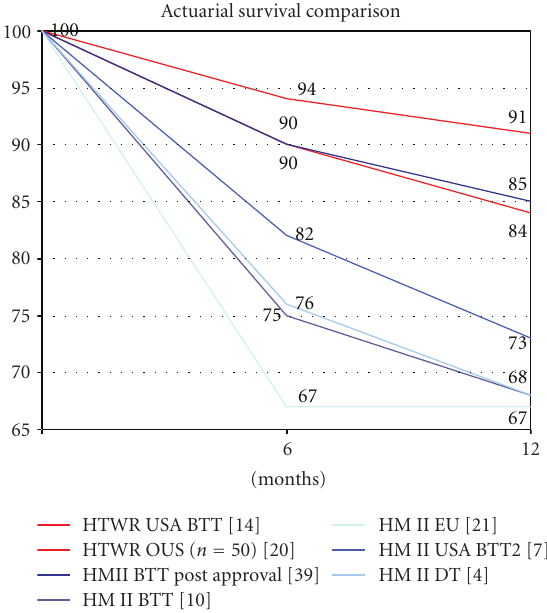
Figure 5: Actuarial survival comparison between HeartMate studies and HVAD assist device. (1) Results from the US BTT Trial presented at AHA Meeting in November by Aaronson [14], (2) Str¨uber et al. 2010 [20], (3) Miller et al. 2007 [10], (4) HeartMate II Post-approvel study [39], (5) Str¨uber et al. 2008 [21], (6) Pagani